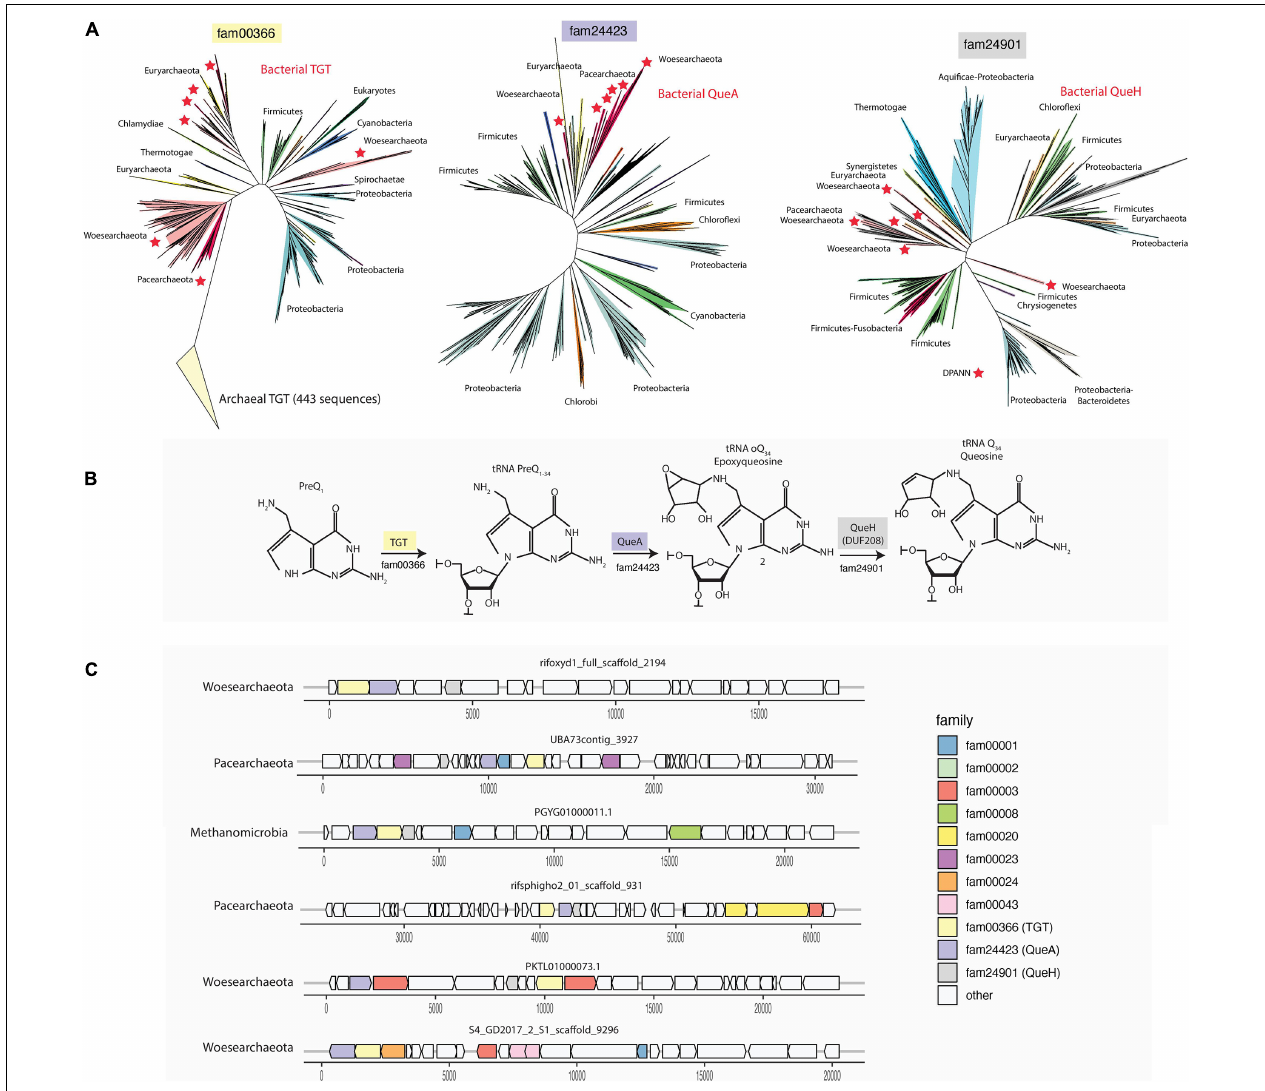
FIGURE 4 | Bacterial queuosine pathway in DPANN genomes and some Euryarchaeota (Methanosarcinales). (A) Phylogenetic affiliation and distribution of the identified QueA, QueH and TGT in archaea selected for this study. (B) The three last steps of the queuosine biosynthesis pathway in Bacteria. (C) Selected examples of genomic context and gene synteny around the genes QueA, QueH (DUF208) and TGT. QueA, S-adenosylmethionine:tRNA ribosyltransferase-isomerase; QueH (DUF208), epoxyqueuosine reductase; TGT, queuine tRNA-ribosyltransferase. A full gene synteny and genomic context of all the genes involved in the queuosine pathway in this study is available in Supplementary Table 5